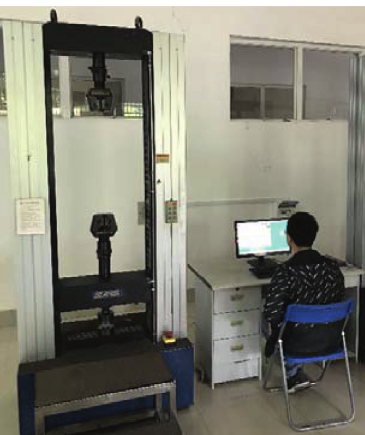
Figure 1: Static Brazilian test with the SANS material testing